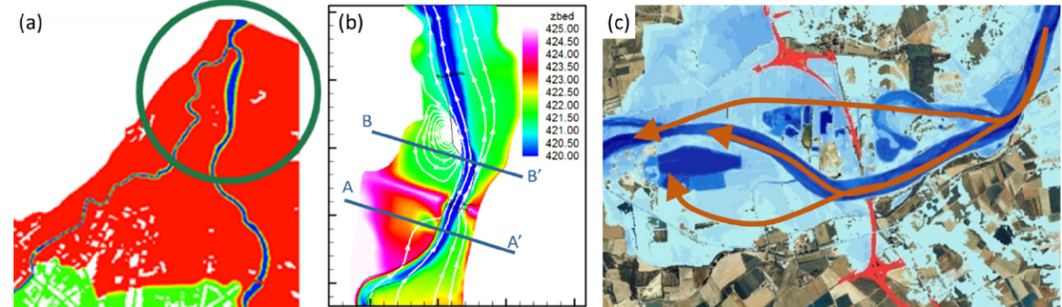
Figure 2. Typical situations in which the 1D assumptions are clearly invalid. River confluence ( a ), recirculation zones generated by the expansion of streamlines downstream of a bridge section ( b ) and flow paths in the main channel and floodplains during high ‐ flow conditions ( c ).